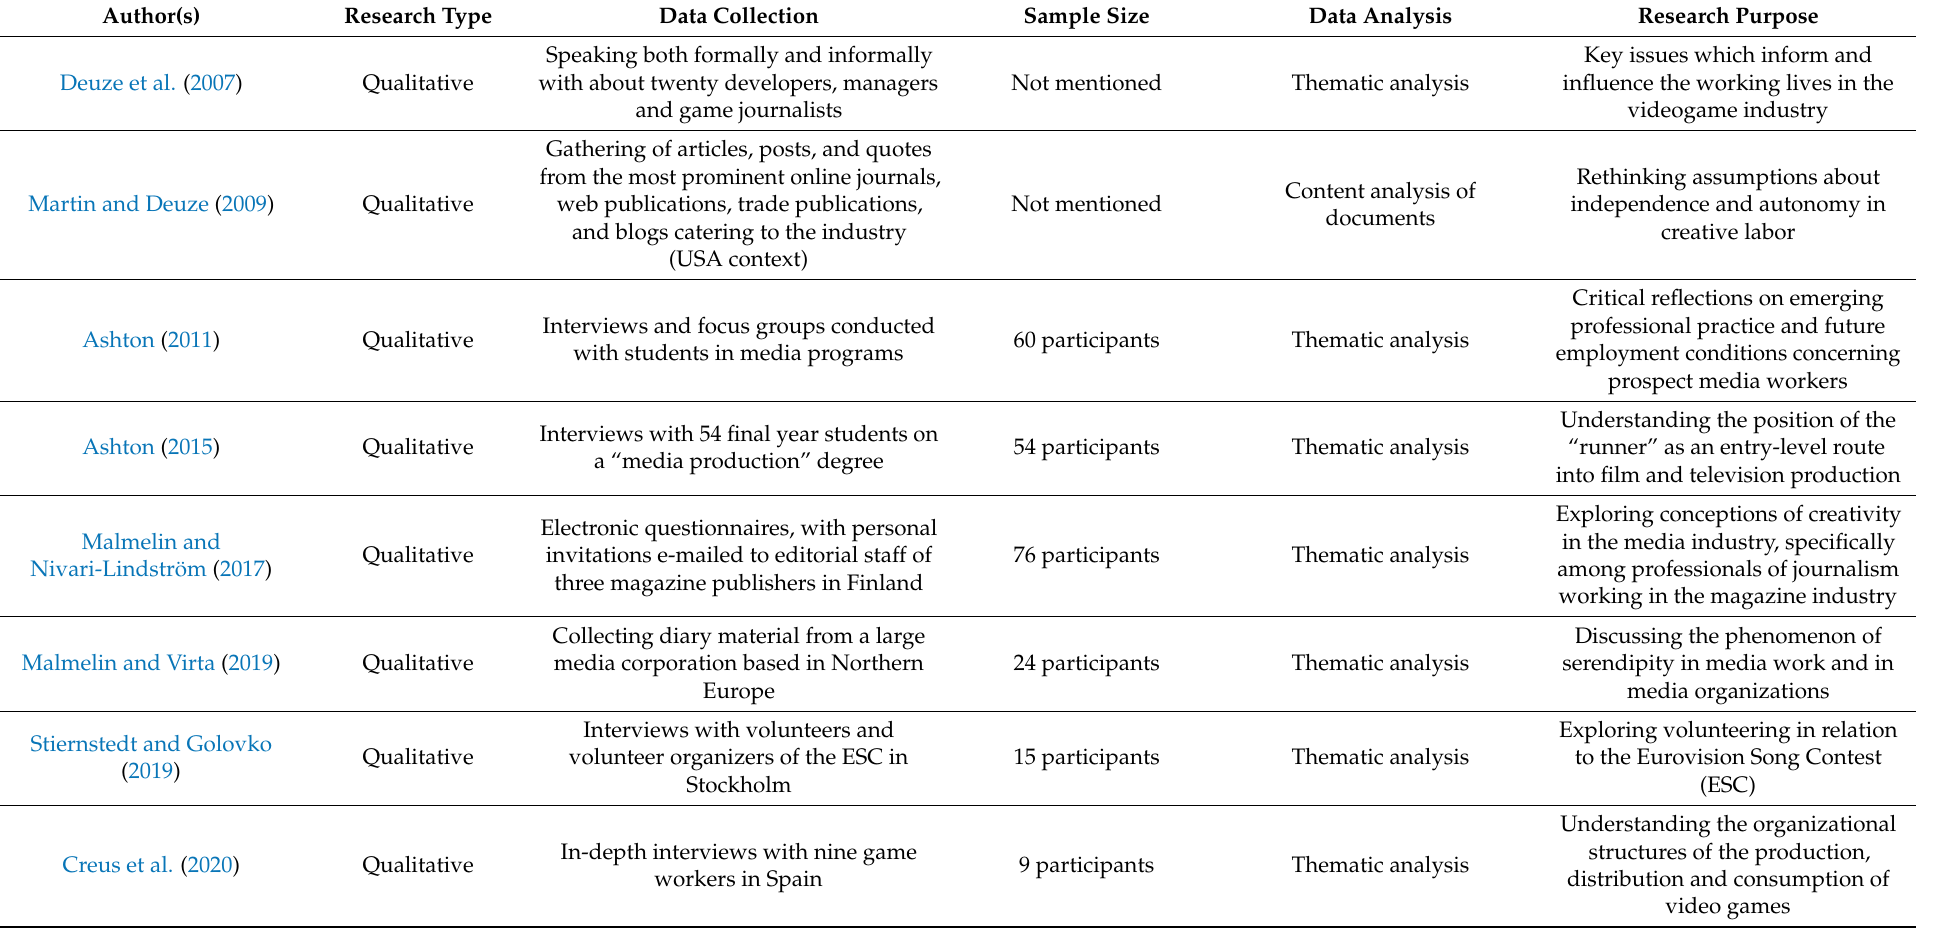
Table 4. Distribution of papers in the subtheme “professional